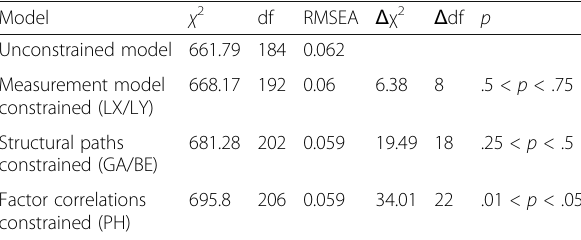
Table 2 Cross-validation